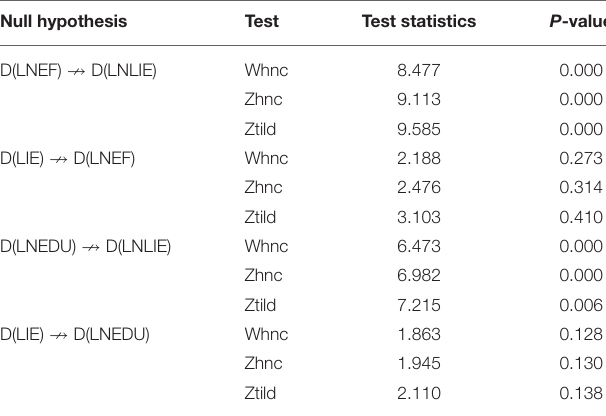
TABLE 7 | Results of the Dumitrescu and Hurlin (47) causality